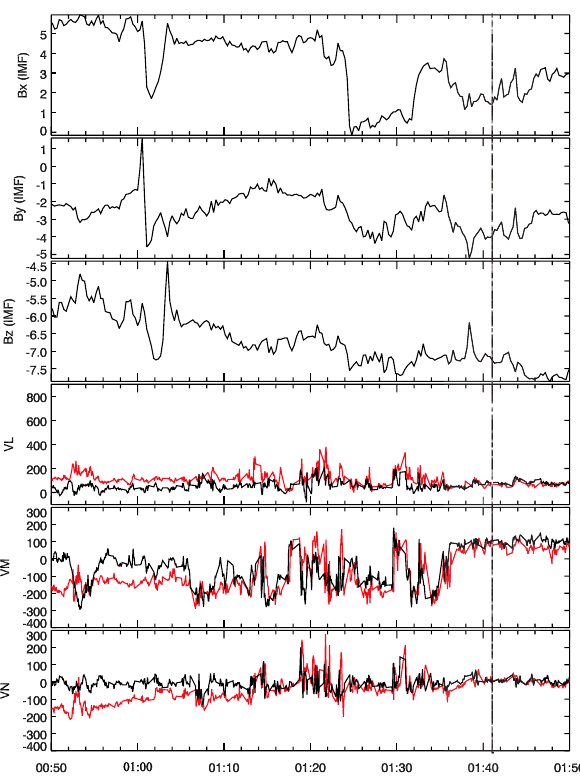
Figure 7 Fig. 7. Comparison between the predicted ion bulk flow velocity and the data for the second type of boundary crossing with large magnetic shear. It has a similar format as Fig. 7, except for the green asterisks, which show the theoretical calculation when the density is above 5cm − 3 , to avoid an inappropriate comparison in the region inside the magnetopause which is no longer a rotational